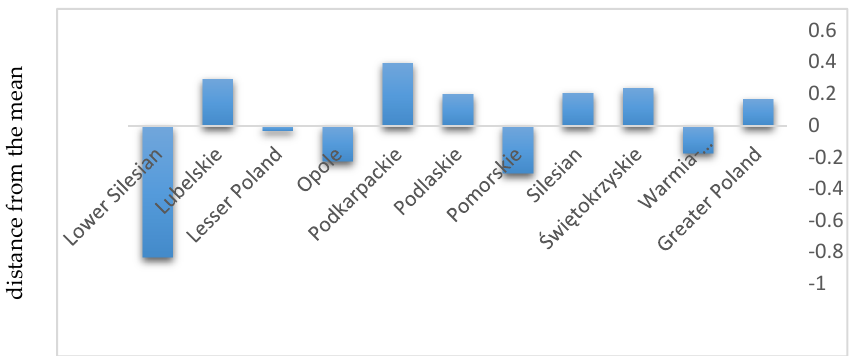
Figure 2. Differences in the levels of decomposed intercepts in imperatives DKT and DET. “0” means the value of the average level of parameter estimations with artificial variables for the provinces under study. Source: own study.